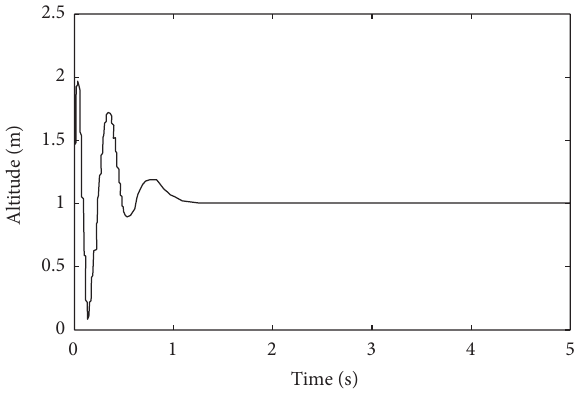
Figure 14: Altitude control of trirotor